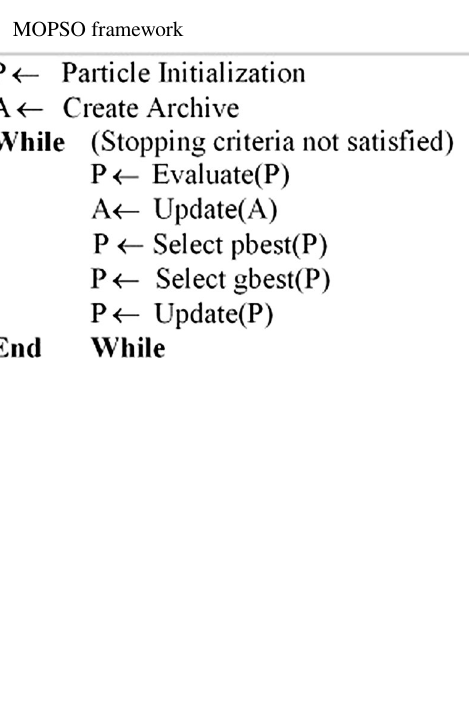
Fig. 14. Based on the convergence graph for surface rough- ness, tool wear, and MRR, the estimated and measured val- ues for responses are represented in Table 17.